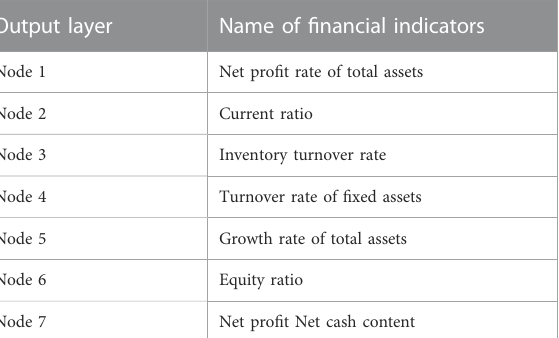
TABLE 1 Corresponding indicators of the input layer.